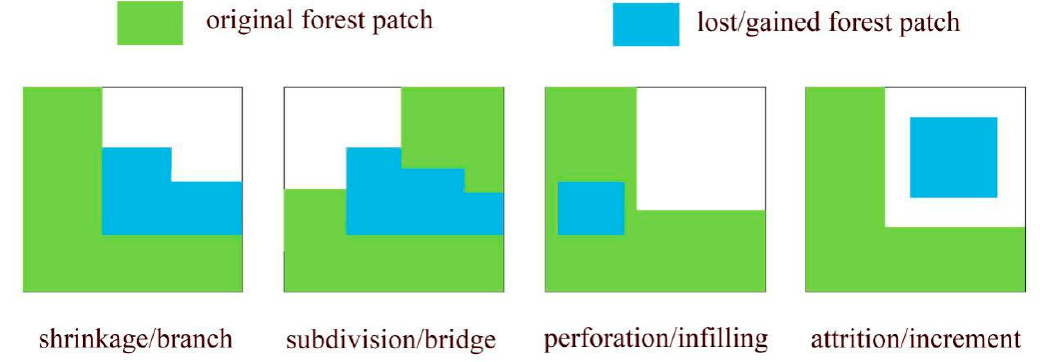
Figure 3. Schematic diagram of forest loss and restoration process analysis.